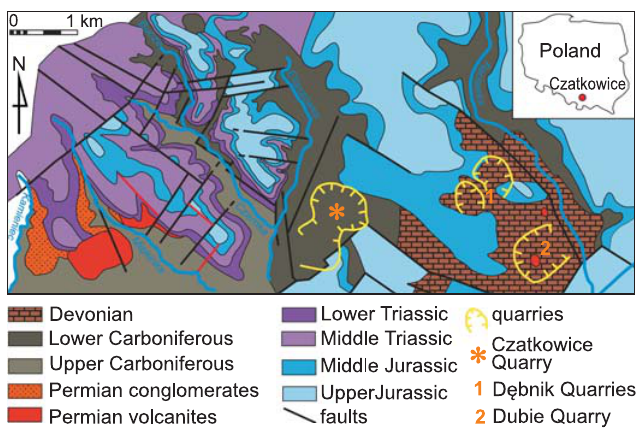
Fig. 1. Geographical position of the investigated specimen (map after Salata 2013, with